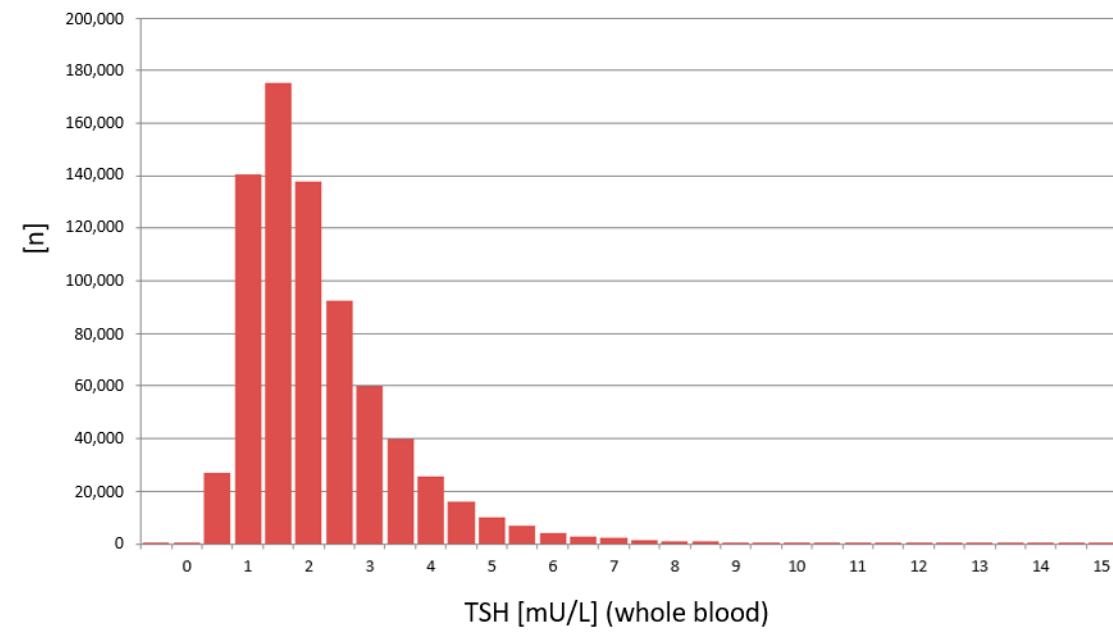
Figure 5. Distribution of TSH values measured on the PE/GSP platform ( n = 748,180).